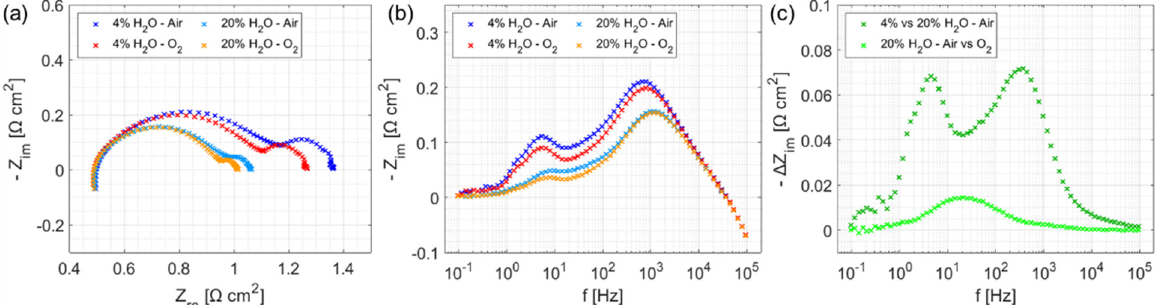
Figure 3. EIS of the ceramic SoA cell ( a ) Nyquist plot, ( b ) Bode plot, and at 650 °C, 20% and 4% H 2 O/H 2 to the fuel electrode vs. O 2 and air to the oxygen electrode, and ( c ) Delta (difference) Bode plot, 20% vs. 4% fuel humidity to the fuel electrode and air vs. O 2 to the oxygen electrode.